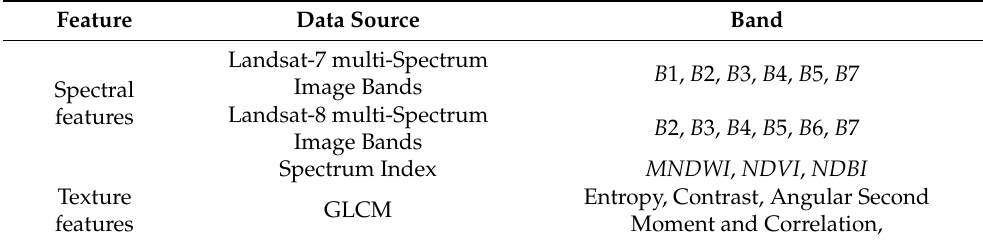
Table 2. Classification feature